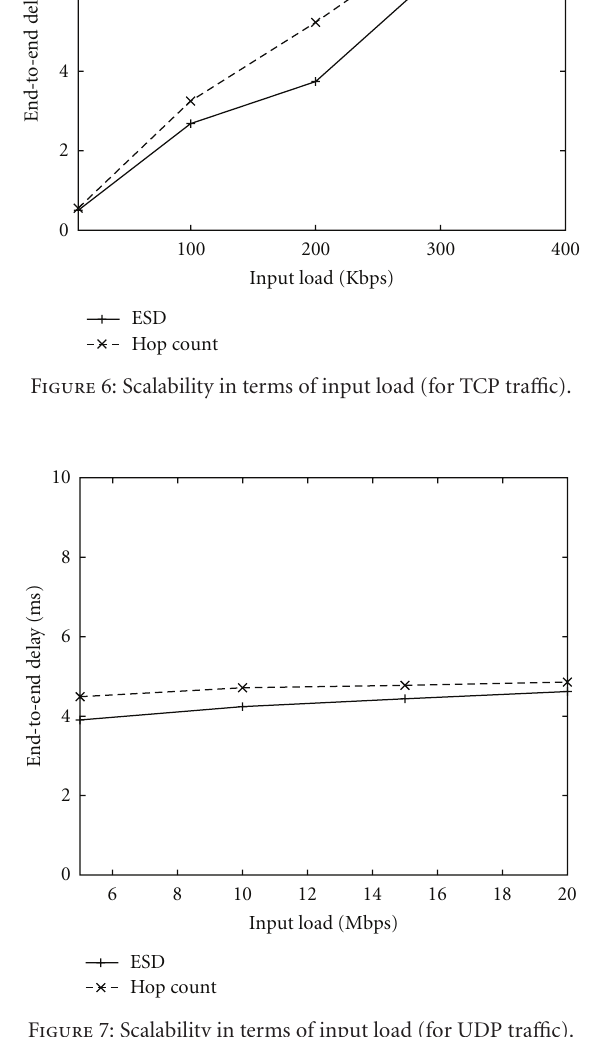
Figure 7: Scalability in terms of input load (for UDP tra ffi c).